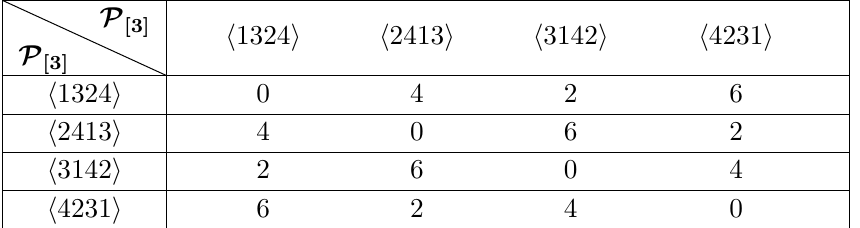
Table 3. { V M } − { V M } two-point correlator